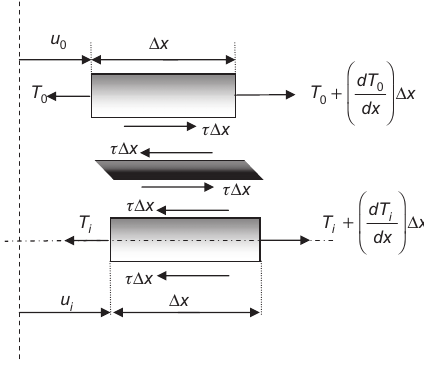
Figure 2 Free body-diagrams of the joint.